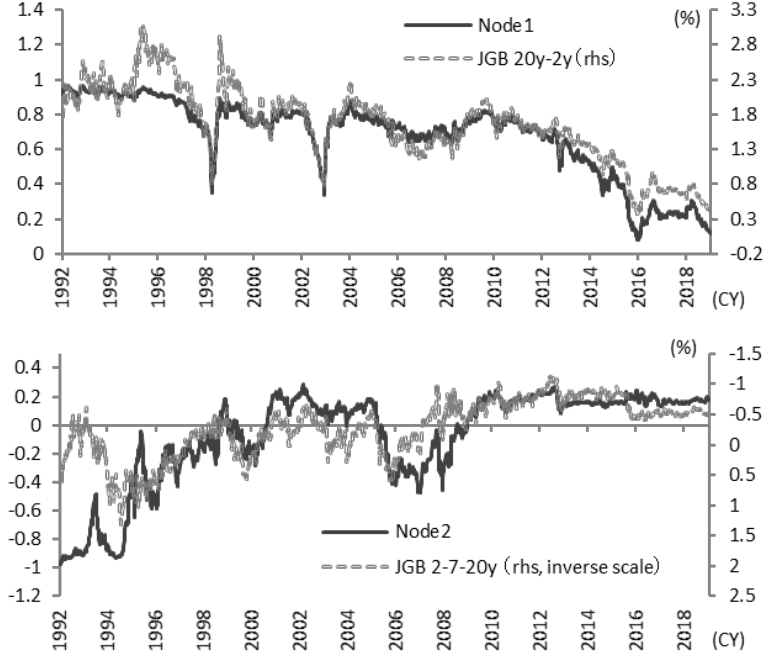
Figure 10. Plots of the hidden layer nodes’ output corresponding to the interest rate spreads.